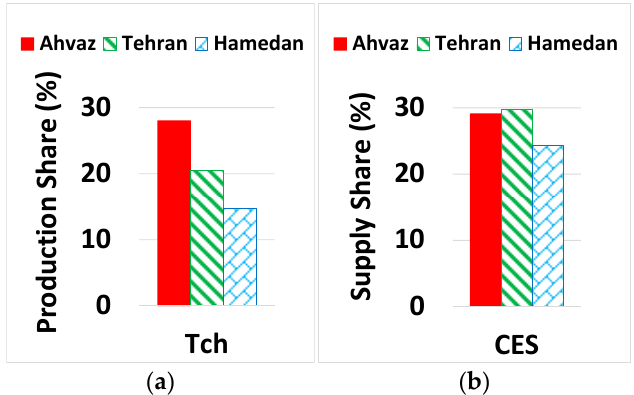
Figure 11. Share of cooling production by the thermal chiller (Tch) ( a ) and the share of cold storage in cooling demand supply ( b ).